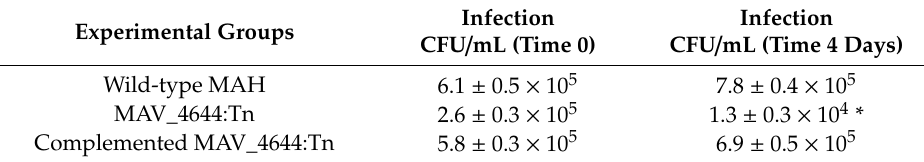
Table 3. The MAV_4644:Tn complemented clone survival in Raw 264.7 macrophages. Experimental Groups